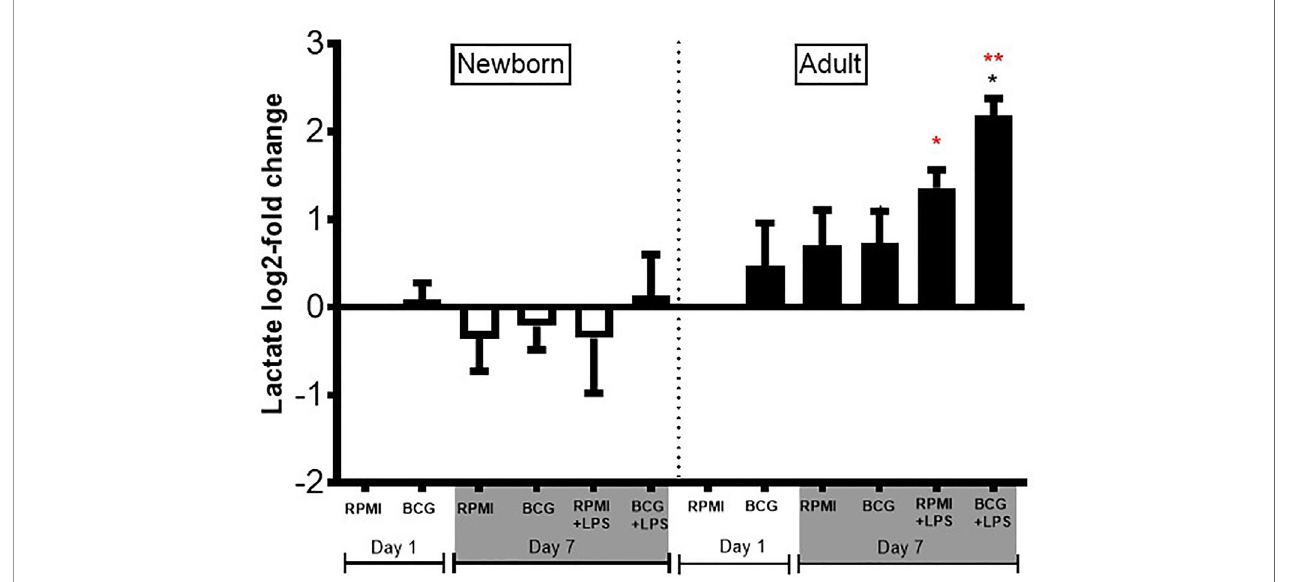
FIGURE 7 | Diminished lactate production in human newborn vs. adult monocytes. Human newborn and adult CD33+ monocytes were cultured in vitro as described in Figure 1 . Lactate was measured in culture supernatants post-primary BCG stimulation (Day 1) and post-secondary LPS stimulation (Day 7) using a colorimetric assay as described in Methods . Lactate production was normalized to the vehicle condition on Day 1 and log 2 -transformed. N = 4 newborns and 4 adults. Bars indicate mean + SD. * p ≤ 0.05 , ** p ≤ 0.01 (black star: log 2 -fold change compared to untrained control RPMI+LPS at Day 7; red stars: NB vs. AD for the respective